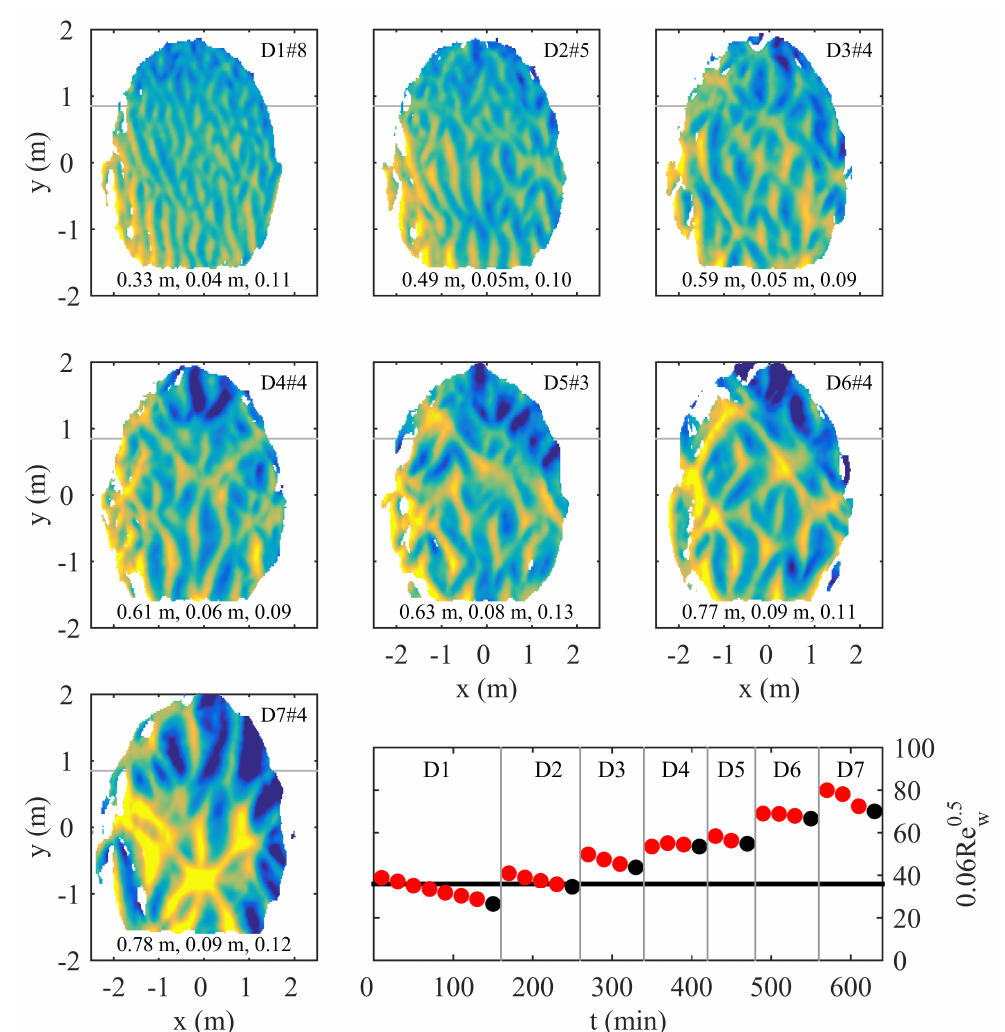
Figure 8. Bed elevation models for selected tests and runs during series D. Warm (yellow) colours are ripple crests, cold (blue) colours are ripple troughs. The colors range from − 0 . 08 to 0 . 08 m. DX#Y stands for run Y in test DX. The local x and y coordinates are relative to the sonar, with ( x, y ) = (0 , 0) vertically below the sonar, and with x positive onshore. The local x = 0 m corresponds to x = 63 . 1 m in Figure 1. The nearest flume wall is at y = − 1 . 65 m. The 3 numbers at the bottom of each panel are the ripple wavelength λ height η and steepness ϑ based on the profile data. The center line of the flume is indicated r r by the gray line. The forcing conditions are expressed as a time series of 0 . 06 Re 0 . 5 t = 0 is the start of series D. The horizontal black line is the particle Reynolds number Re The black dots represent the times of the shown bed elevation